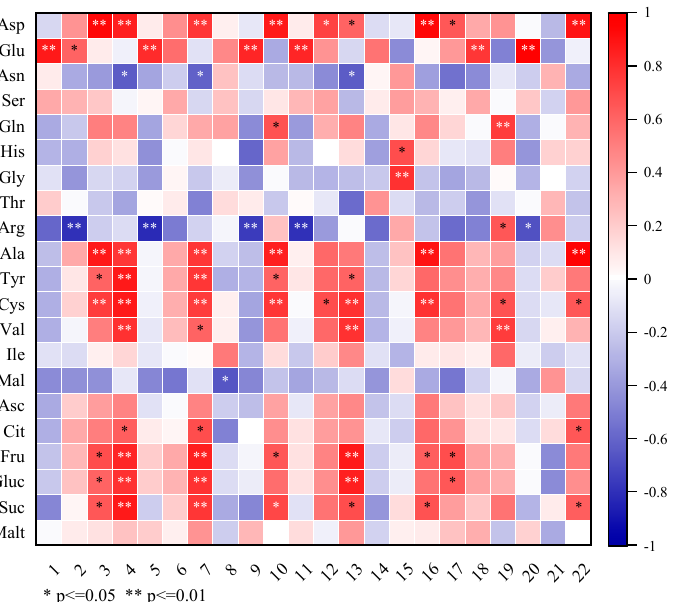
Figure 4. Pearson’s correlation analysis based on the contents of volatile and nonvolatile flavor compounds in the samples during the drying processes. Numbers 1~22 are the corresponding codes for the 22 kinds of volatile compounds in Table 1. The abbreviated words represent the nonvolatile flavor compounds in Table 2.